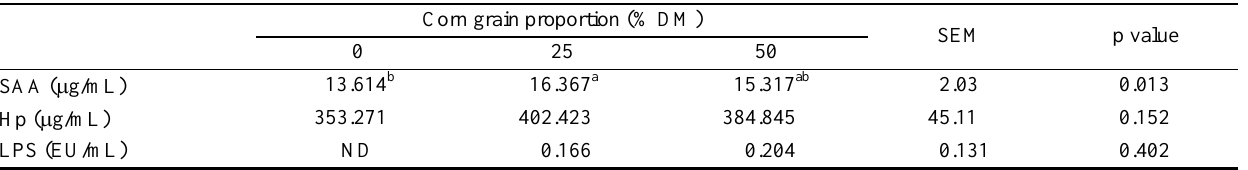
Table 3. The SAA , Hp and LPS concentrations in blood